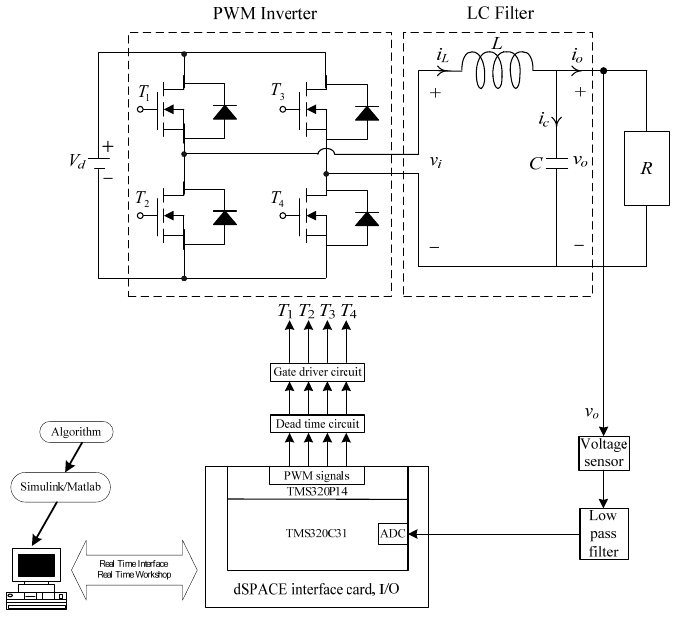
Figure 5. Block diagram of the experimentation.